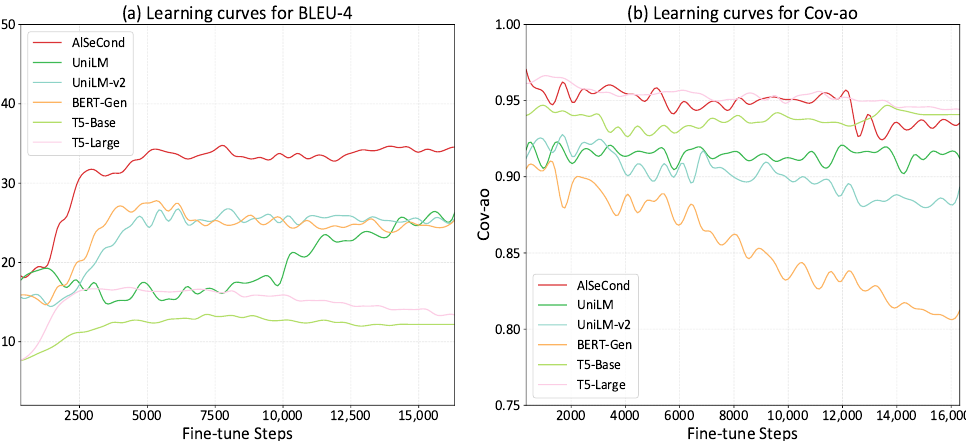
Figure 7. Learning curves for fine-tuning models with the labeled dataset. ( a ) illustrated the learning curves for BLEU-4 changing with fine-tuning steps. ( b ) illustrated the learning curves for Cov-ao changing with fine-tuning